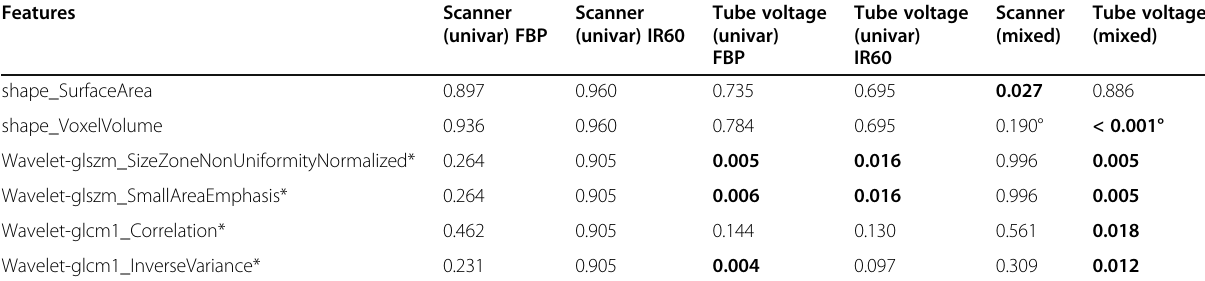
Table 2 FDR-adjusted p values for univariate and multivariable analysis for the effect of scanner and tube voltage